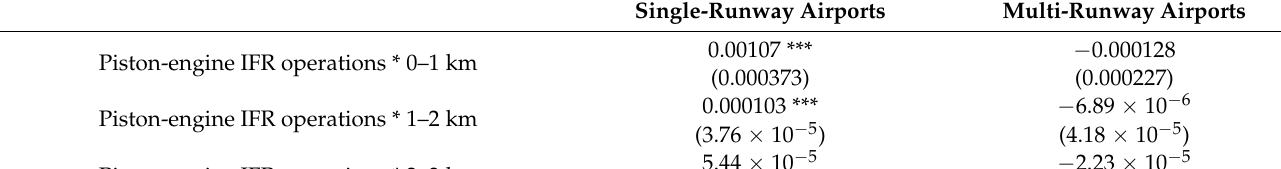
Table 6. Key coefficient results from single regression with 3 km treatment cutoff: Associations be- tween annual piston-engine IFR operations and wind direction and age 65+ cardiovascular